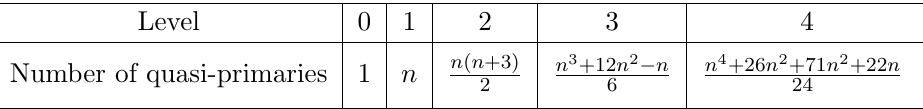
Table 2 . Numbers of quasi-primary operators at each level in the orbifold WCFT. where the partition functions P ( N ) give the number of operators at the level N . We get the number of quasi-primary operators by subtraction. The numbers are listed in table 2. The explicit forms of the quasi-primary operators at each level are listed as